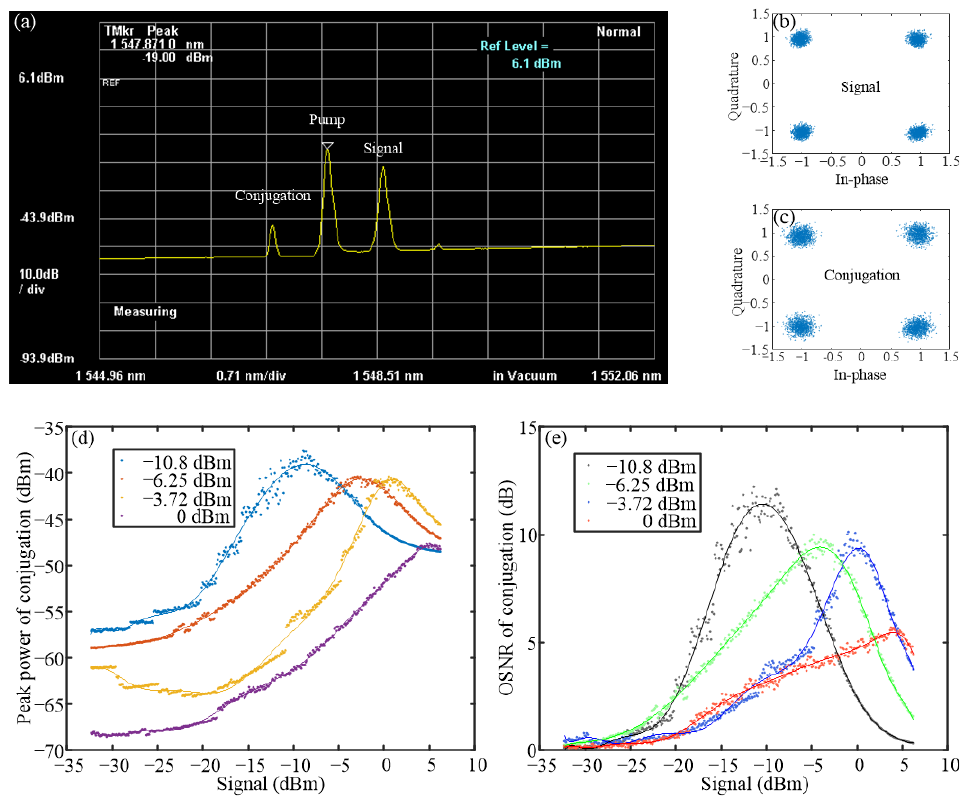
Figure 8. The result of the experiment in XF case; ( a ) spectrum; constellation results of input signal ( b ) and the conjugated signal ( c ); ( d ) power transfer function; ( e ) OSNR curve. (dots: experimental data; solid: fitting curve).